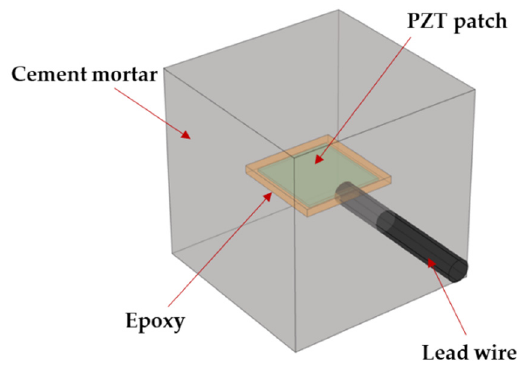
Figure 2. The structure of smart aggregate.